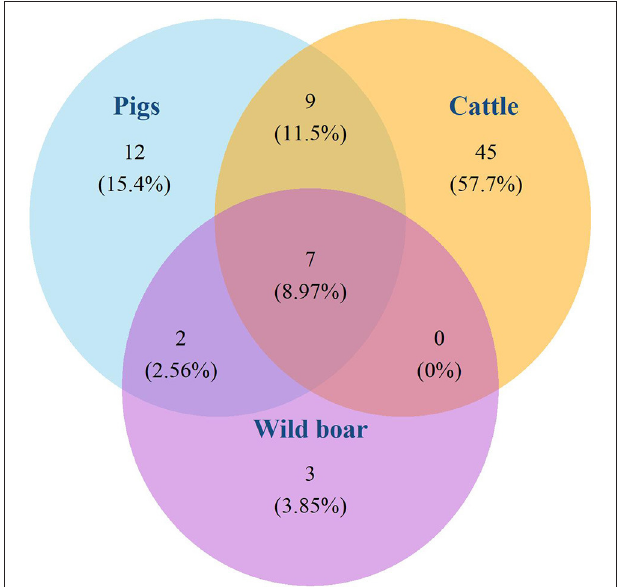
FIGURE 3 | Absolute and relative (%) number of spoligotypes isolated in pigs, wild boars, and cattle, and spoligotypes shared by these species. INTA-CONICET and VISAVET Health Surveillance Center, available at: